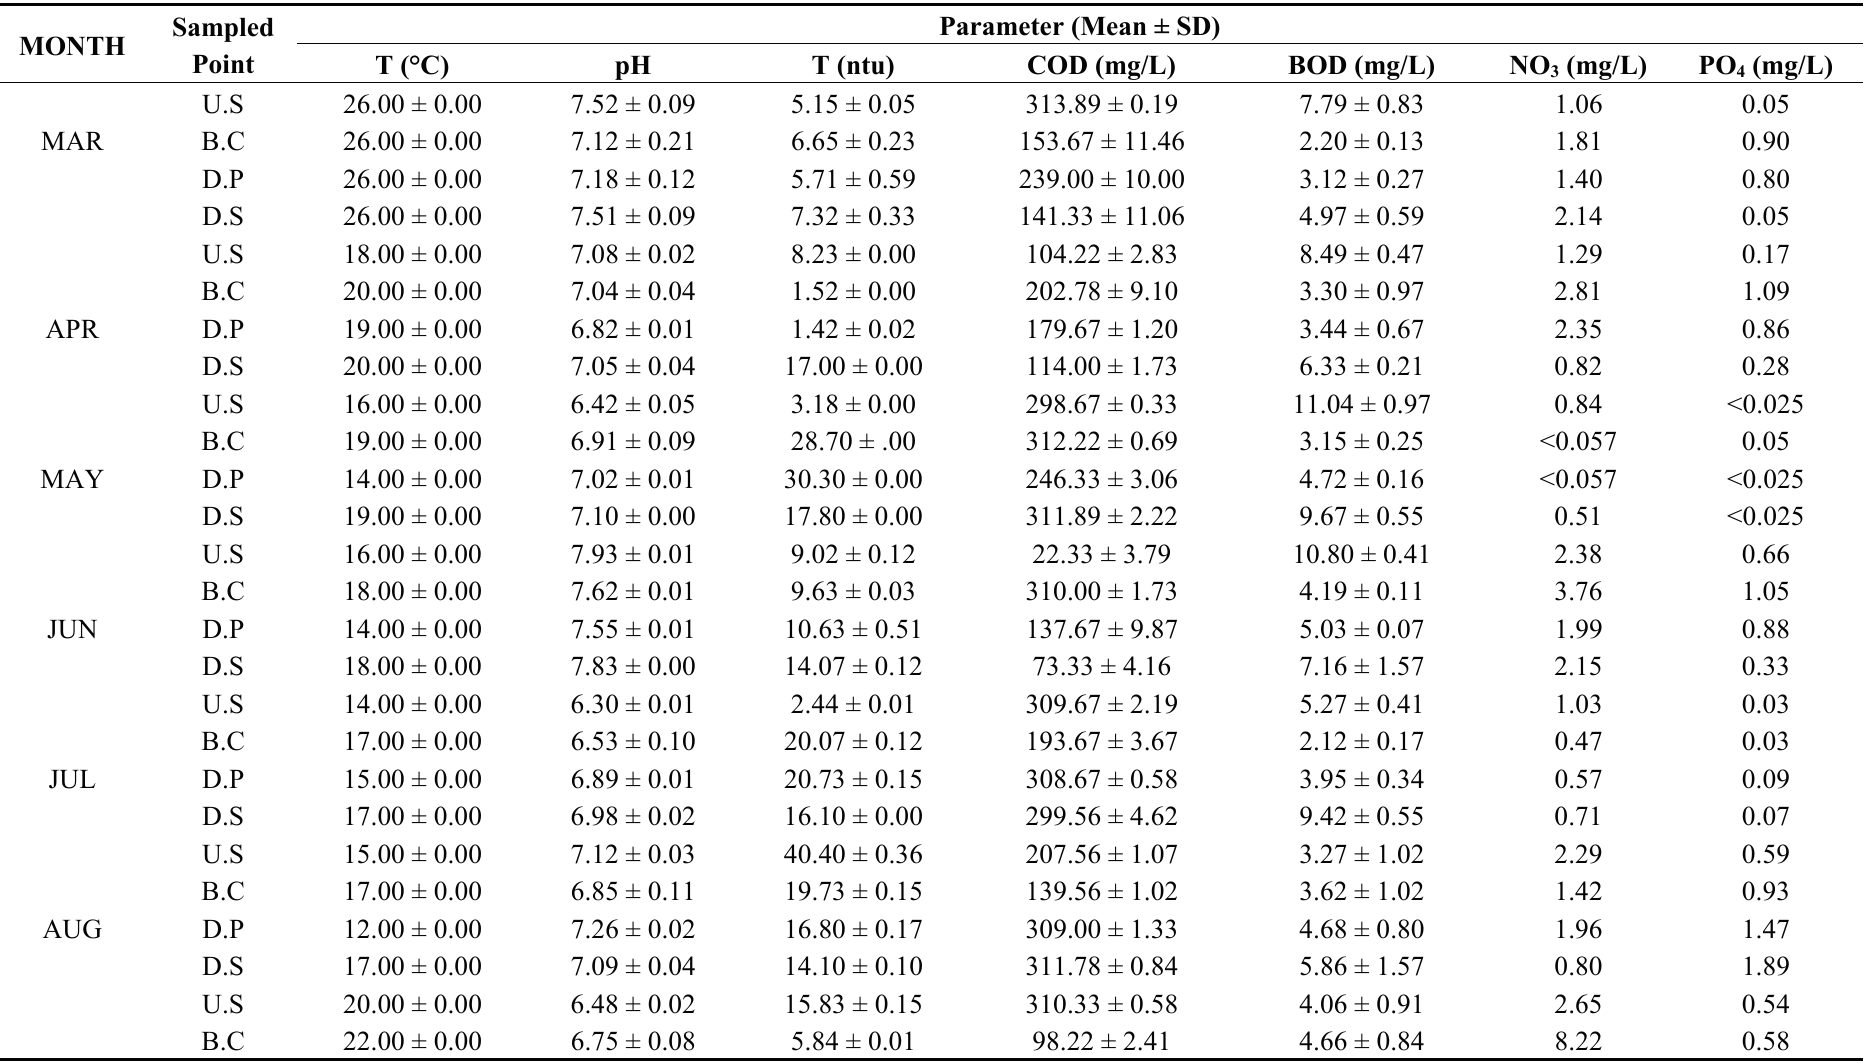
Table 3. Physicochemical parameters of wastewater effluent from New Germany wastewater treatment works and the receiving river